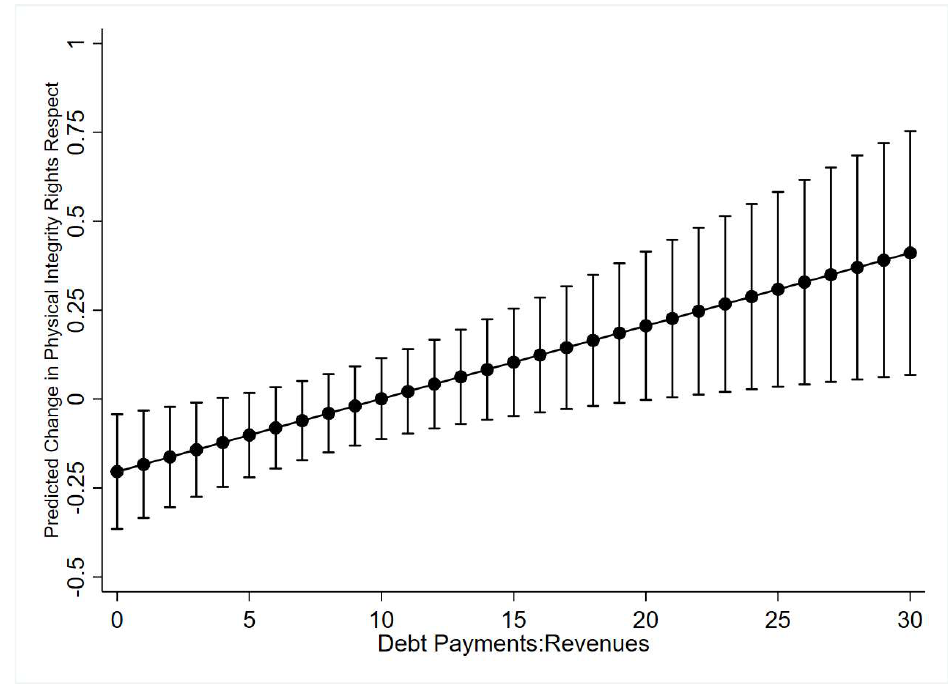
Figure 2. Marginal Effects of Default and Increasing Debt:Revenues (95% CIs).